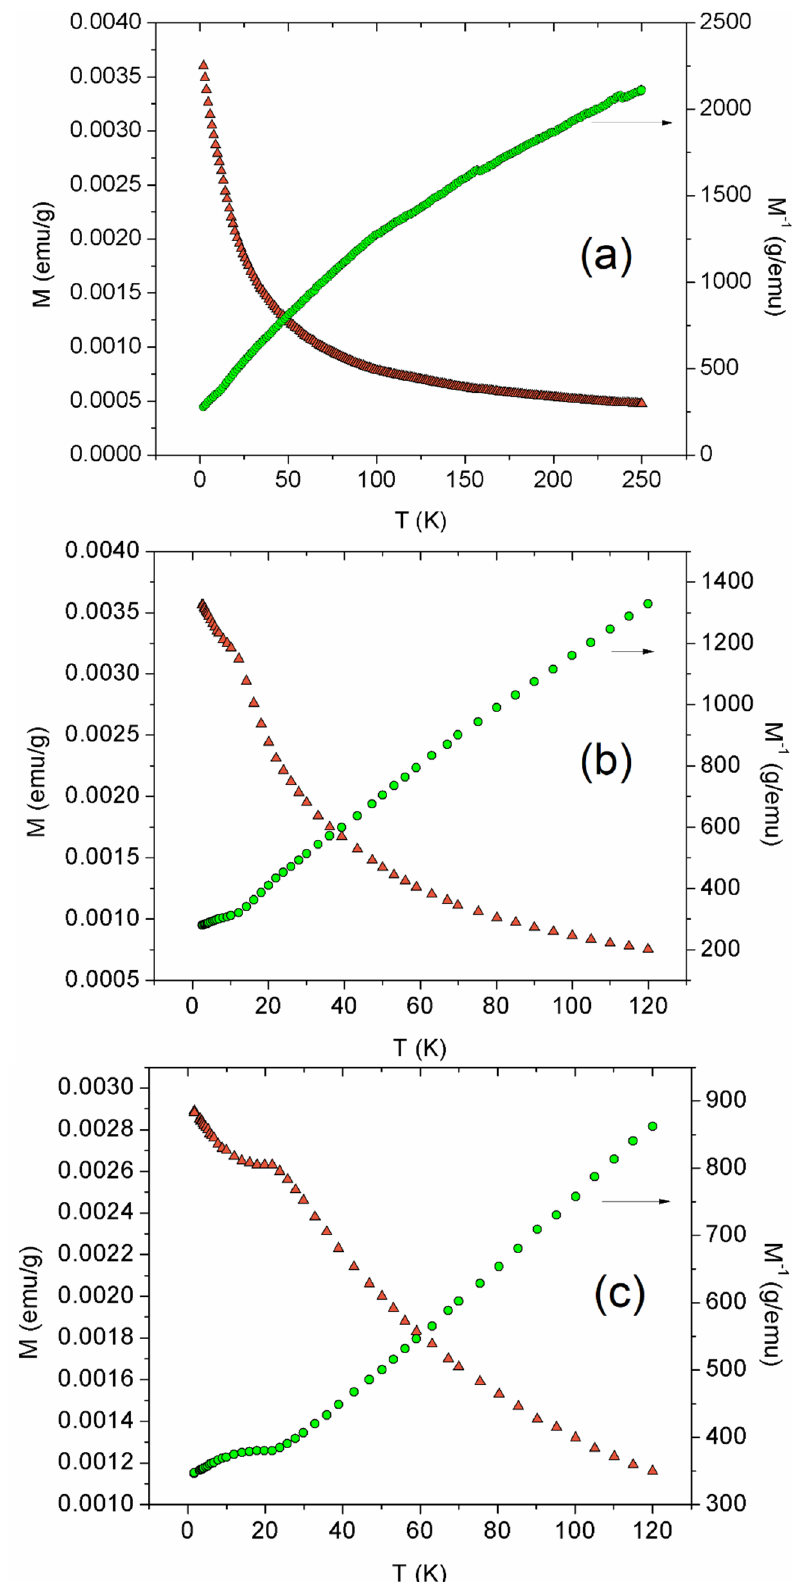
Figure 3. Variation of M along with M − 1 vs. temperature for ( a ) Sample 1, ( b ) Sample 2, and ( c ) Sample 3.